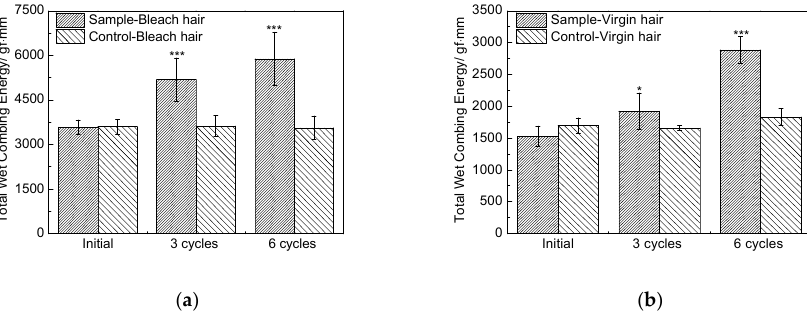
Figure 2. The wet combability of ( a ) bleach hair and ( b ) virgin hair sample (exposed) and control (unexposed, washed by solvents) groups after pre-treatment, and the third and sixth cycles treatment. Note: comparison to the control group, * p < 0.05, *** p < 0.001.